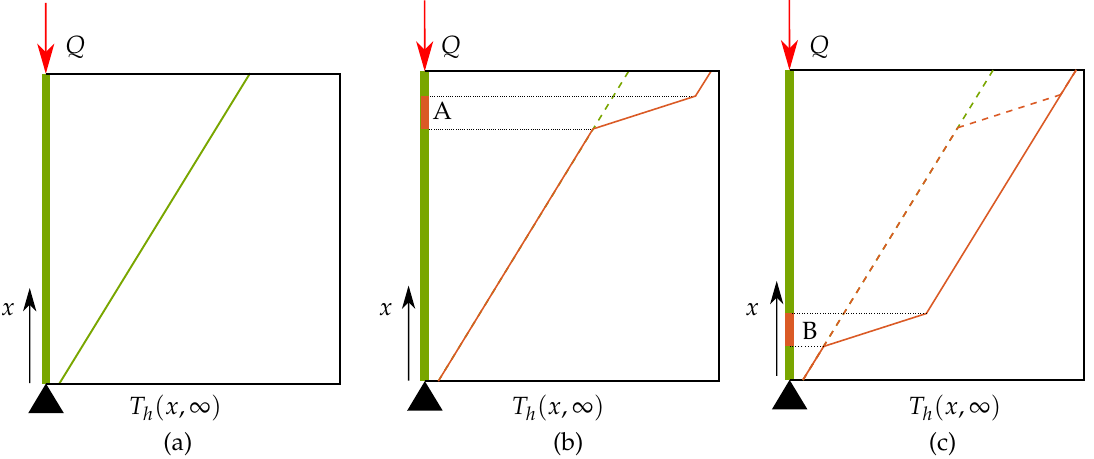
Figure 11. ( a ) Variation of steady-state temperature along the length of the domain as per Equation (21). ( b ) steady-state temperature with a patch of low conductivity located at A ( c ) steady-state temperature with a patch of low conductivity located at